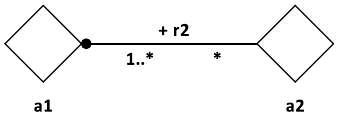
Fig. 10. Graphical representation of a role ( Role ) linking two associations (